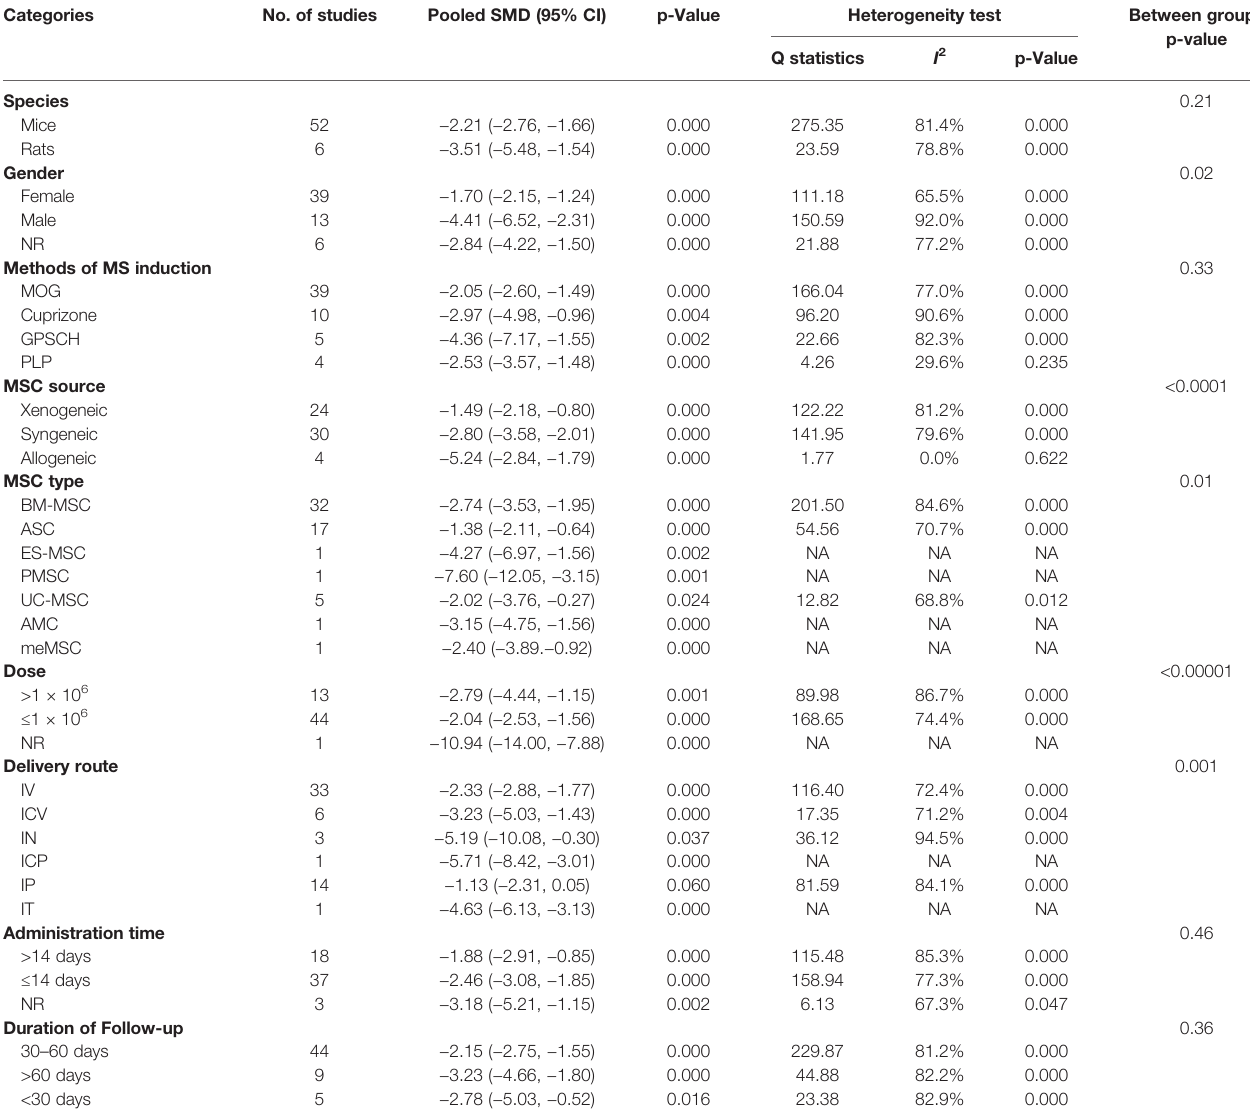
TABLE 3 | Strati fi ed meta-analysis of remyelination. Categories No. of studies Pooled SMD (95% CI)